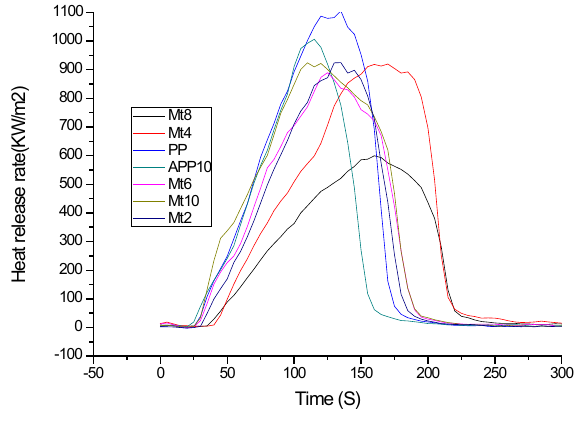
Figure 7: HRR of PP and APP10% and Mt2, Mt4, Mt6, Mt8, Mt10.